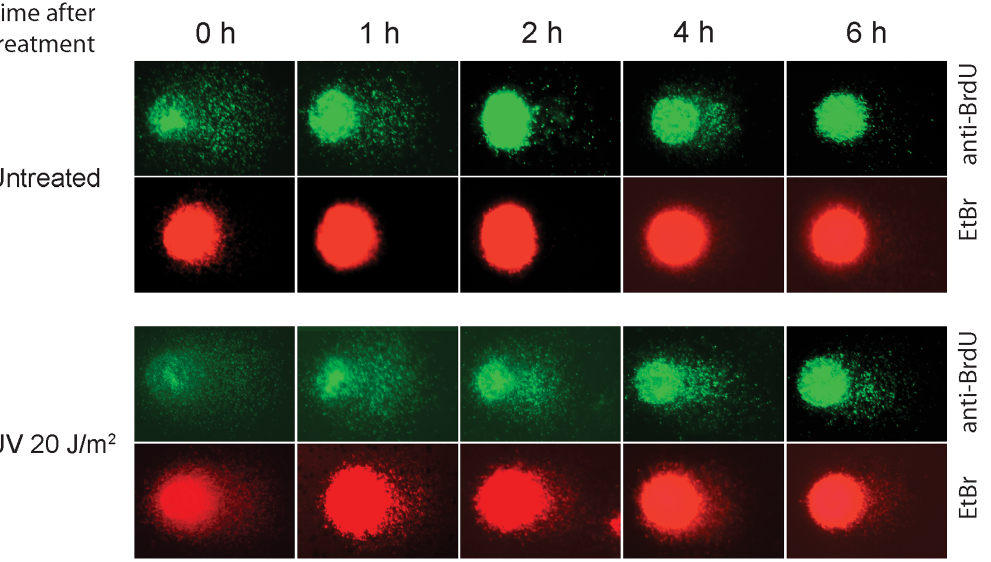
Figure 2. Alkaline BrdU comet PRR assay images of untreated and UV-irradiated HeLa cells representing the progression of replication as detailed in Figure 1. The cells were pulse labelled with BrdU before irradiation with 20 J/m 2 UV-C or mock treatment. After the indicated time (0–6 h) single-stranded DNA fragments were separated from matured DNA by alkaline single cell electrophoresis followed by immunostaining using fluorescent anti-BrdU antibody (green) or staining with ethidium-bromide (red). The much higher sensitivity of the BrdU comet assay as compared to the basic comet assay was demonstrated by showing the anti-BrdU stained and ethidium bromide counterstained images of the same cells.